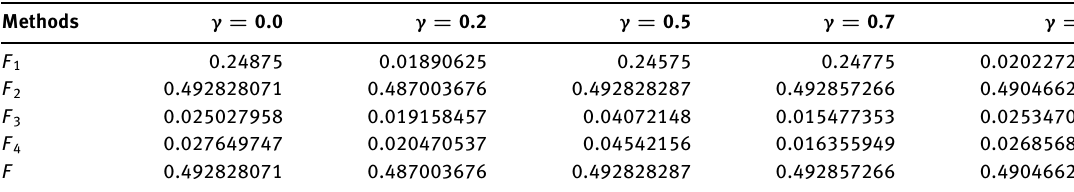
Table 2: Effect of Varying γ Using Chess Dataset.